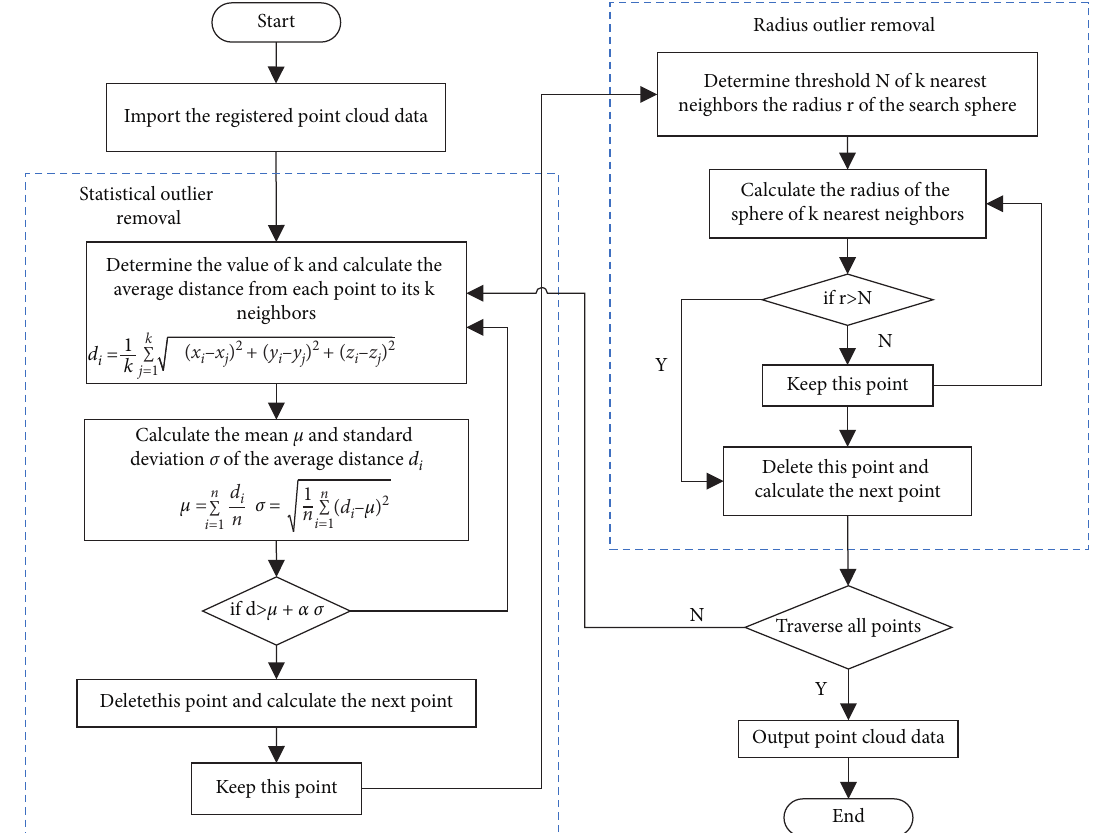
Figure 4: Flowchart of the segmentation algorithm of fruit